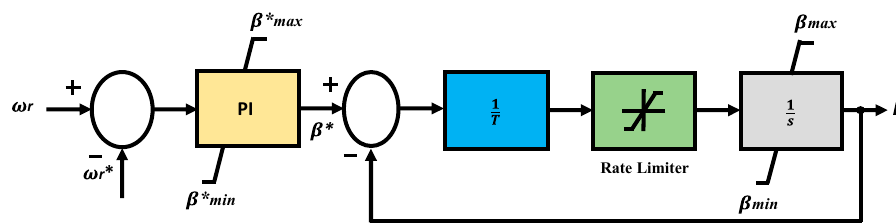
Figure 4. Pitch control scheme for variable-speed wind turbines (VSWT).